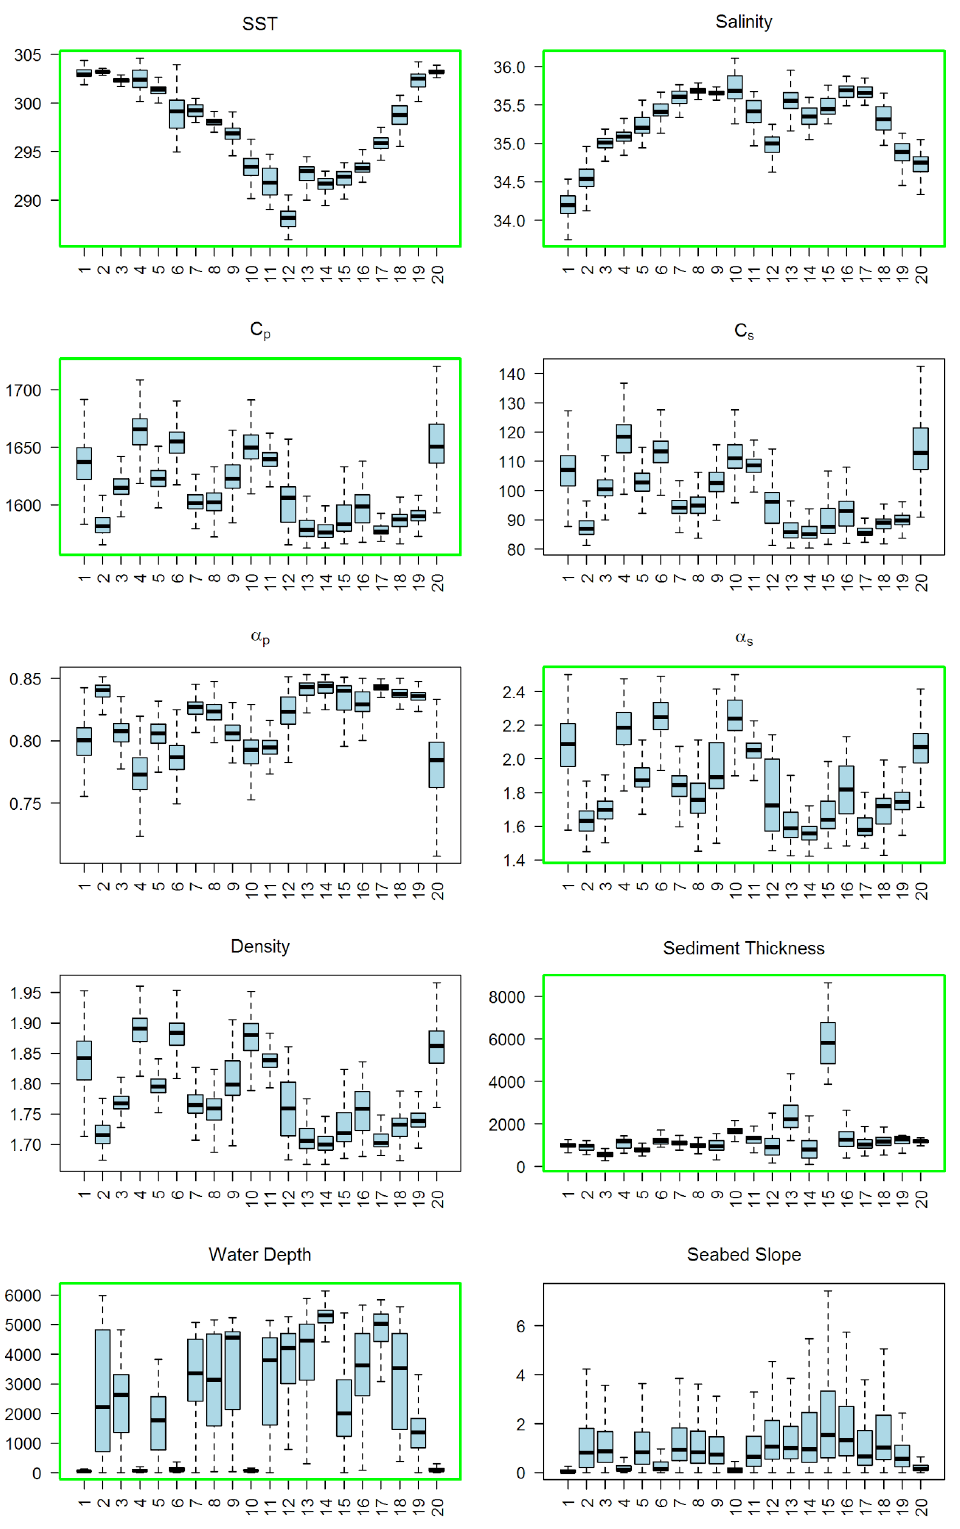
Figure 4. Box-and-whisker plots of various variables by zone (x-axes show zone number): Sea surface temperature (SST) [kelvin], sea surface salinity [psu], compressional sound speed at the seafloor (Cp) [m/s], shear sound speed at the seafloor (Cs) [m/s], compressional absorption coefficient at the seafloor ( ∝ p ) [dB/ λ ], shear absorption coefficient at the seafloor ( ∝ p ) [dB/ λ ], density of the top seafloor layer [1000 kg/m 3 ], thickness of the unconsolidated and consolidated sediment [m], water depth [m], and seabed slope [degrees]. Variables used directly in the clustering model are in green boxes.